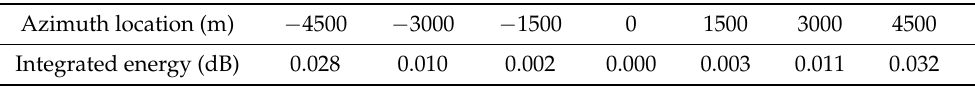
Table 4. Imaging results for targets at azimuth scene center, calibrated with reference EAP. Azimuth location (m) − 4500